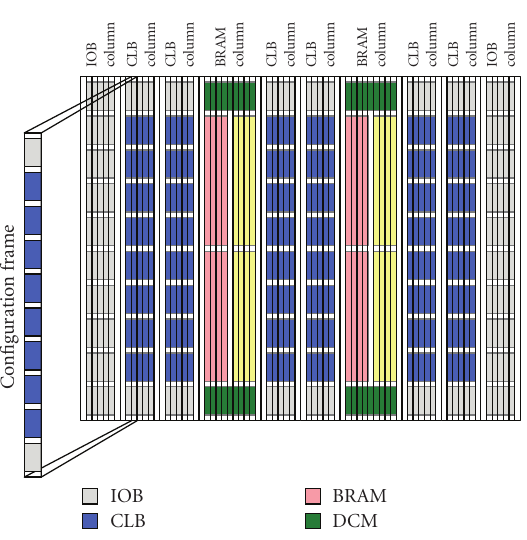
Figure 3: Xilinx virtex configuration architecture [4].